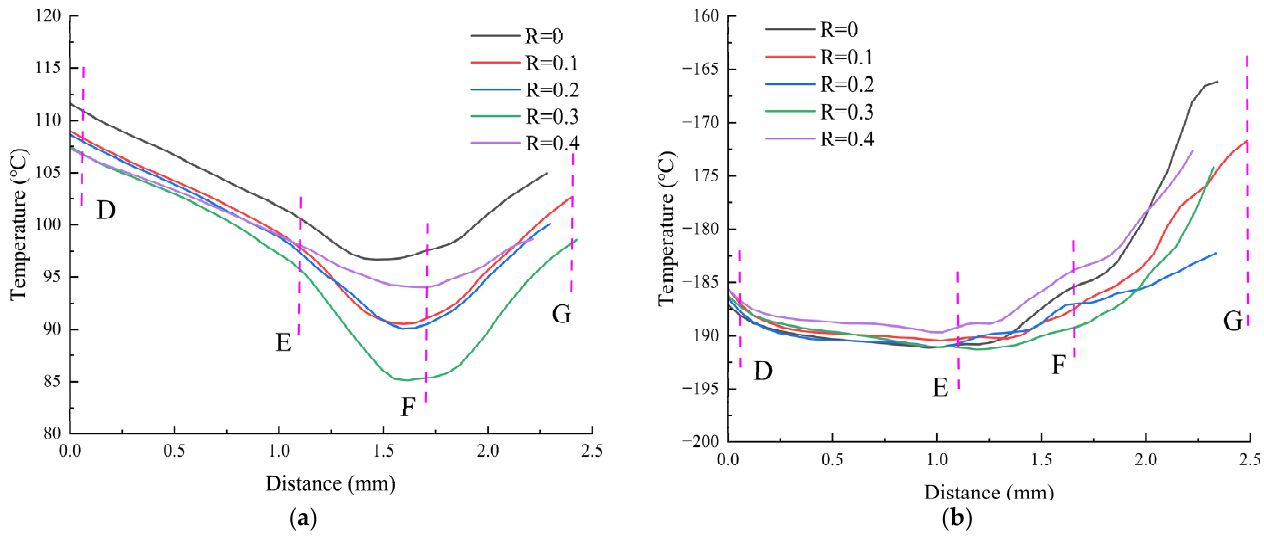
Figure 25. Variation curves of temperature of the fins along the trajectory direction under different